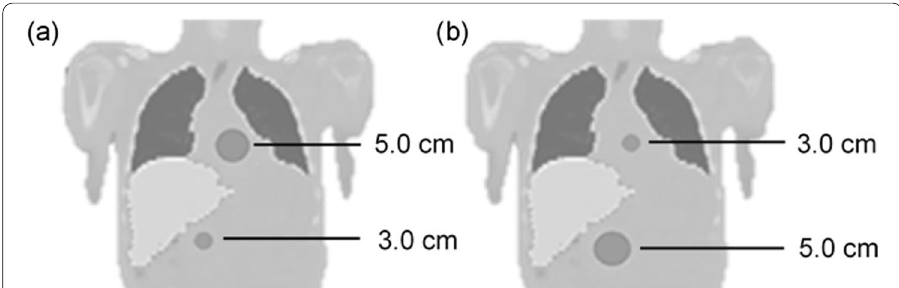
Fig. 2 Segmented coronal CT slices of the voxel-based digital patient phantom with spheres’ positions for a scenario 1 and b scenario